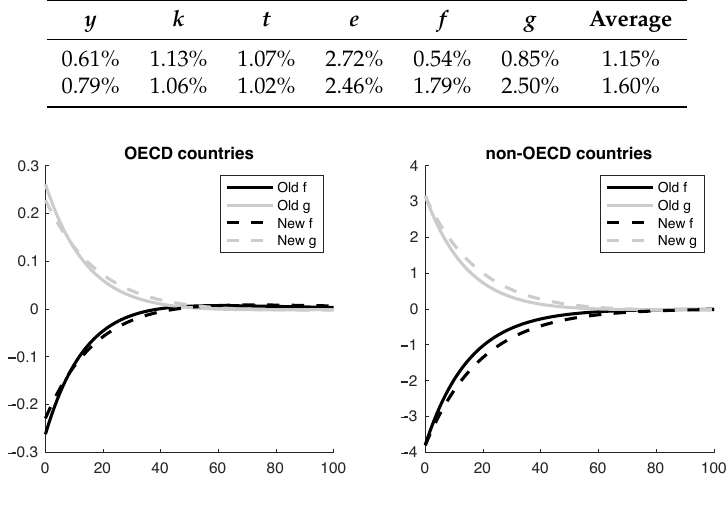
Figure 12. Control variables.